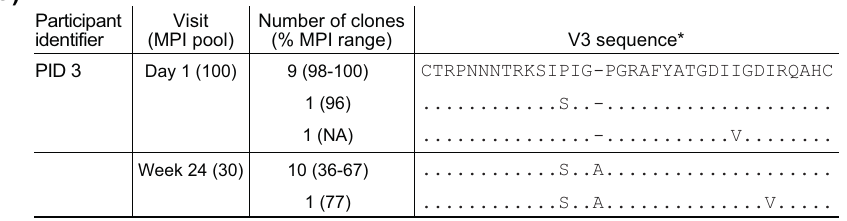
Dots indicate residues identical to the major baseline sequence envs; dashes indicate gaps. *gp120 V3 loop sequence (equivalent to position 296 to 331 in HXB2 (NCBI accession number